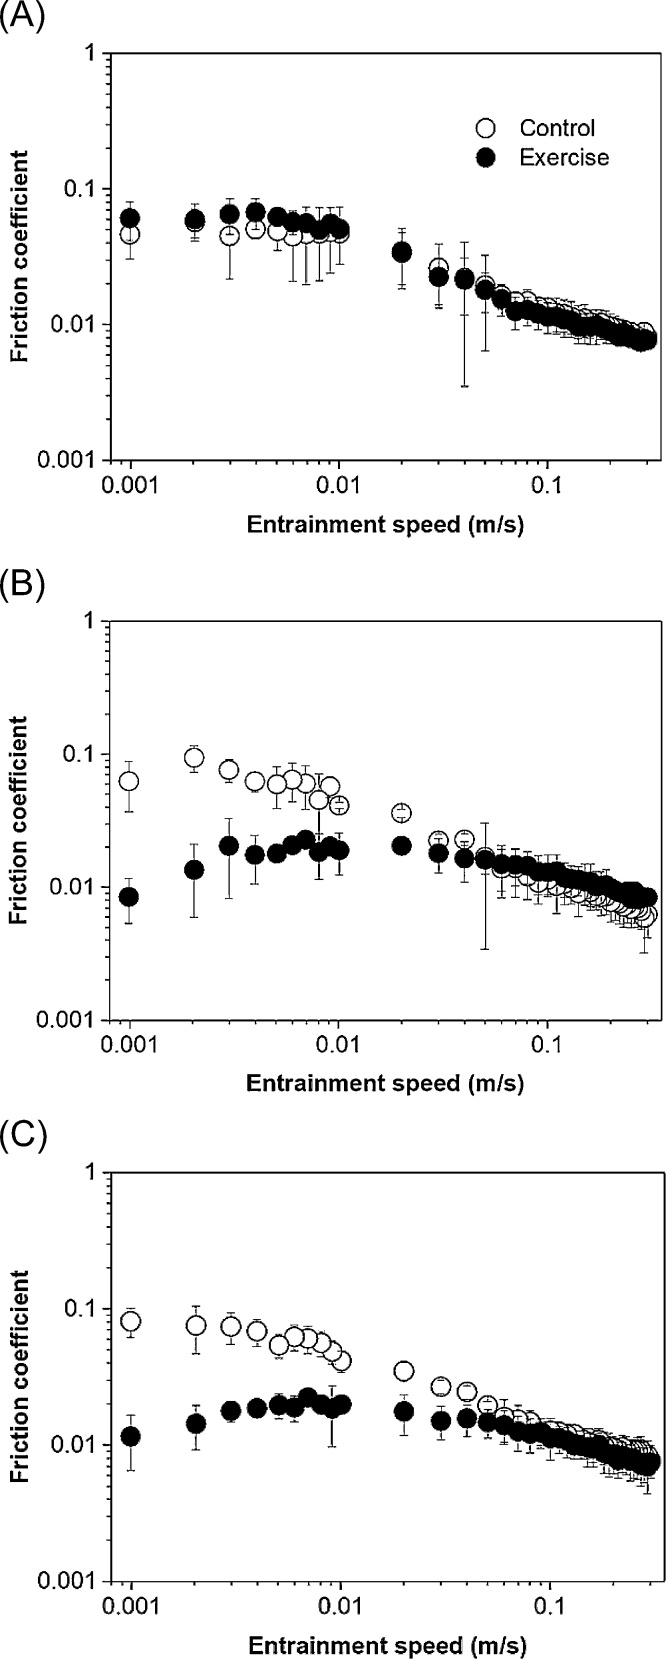
Mean friction coefficients of saliva of participants as a function of entrainment speed before exercise (S0, panel A), immediately post-exercise (S1 panel B) and 1 h post-exercise (S2, panel C) in the Control procedure (open symbols) and Experimental procedure (closed symbols).Error bars represent standard deviations (n = 11).